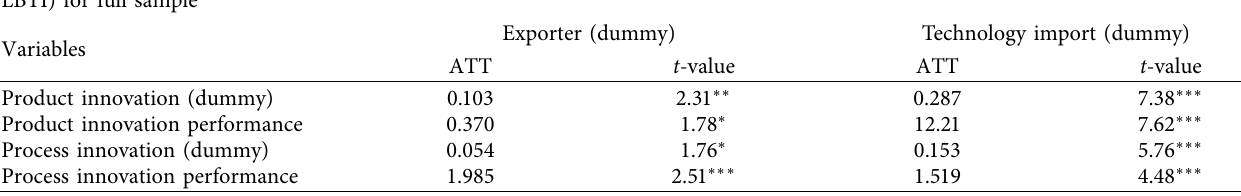
Table 6: The results of PSM (propensity score matching analysis).